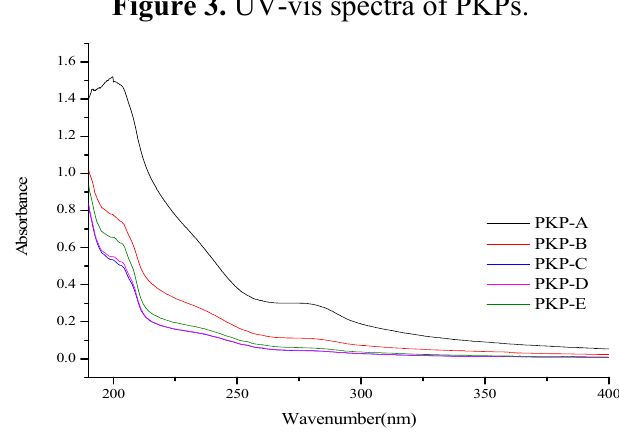
Figure 3. UV-vis spectra of